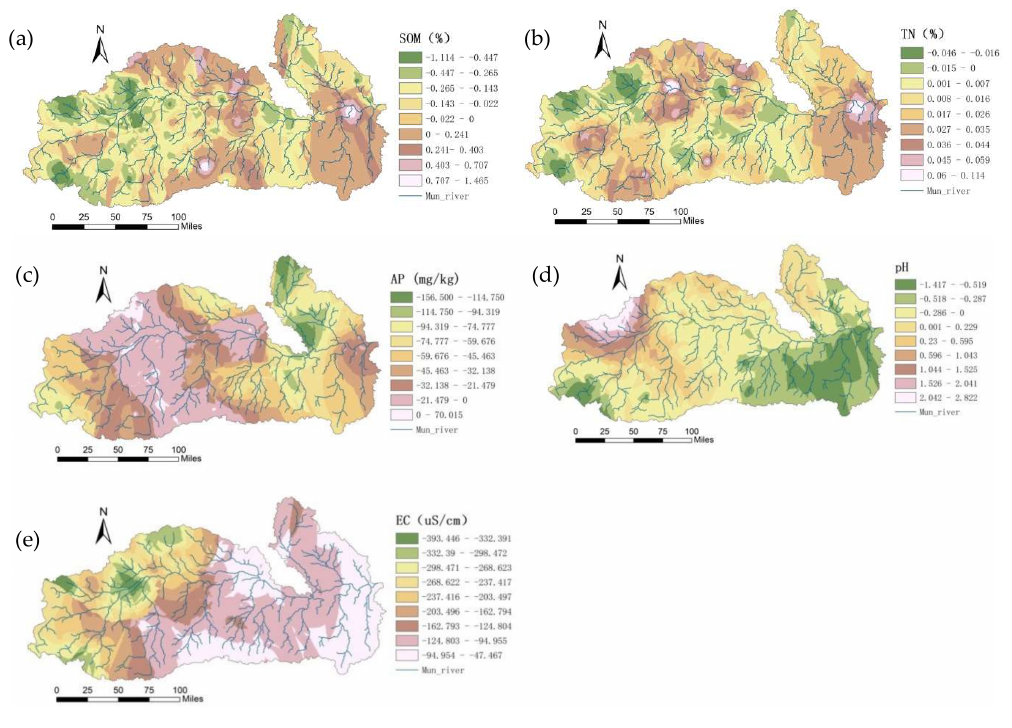
Figure 9. Spatial differences of SOM ( a ), TN ( b ), AP ( c ), pH ( d ), and EC ( e ) between the dry and the rainy